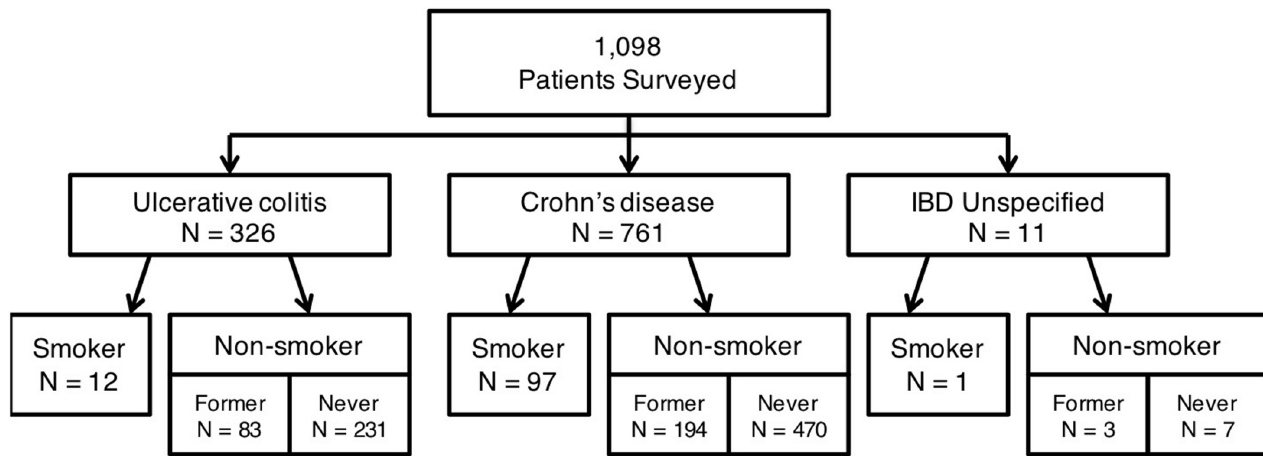
Fig 1. Prevalence of smoking in inflammatory bowel disease. The prevalence of cigarette smoking was determined over 1098 consecutive inflammatory bowel disease (IBD) specialty clinic visits over a 3-month period. IBD diagnosis was determined based on the diagnosis of the treating IBD physician. Smoking status was determined by self-report.